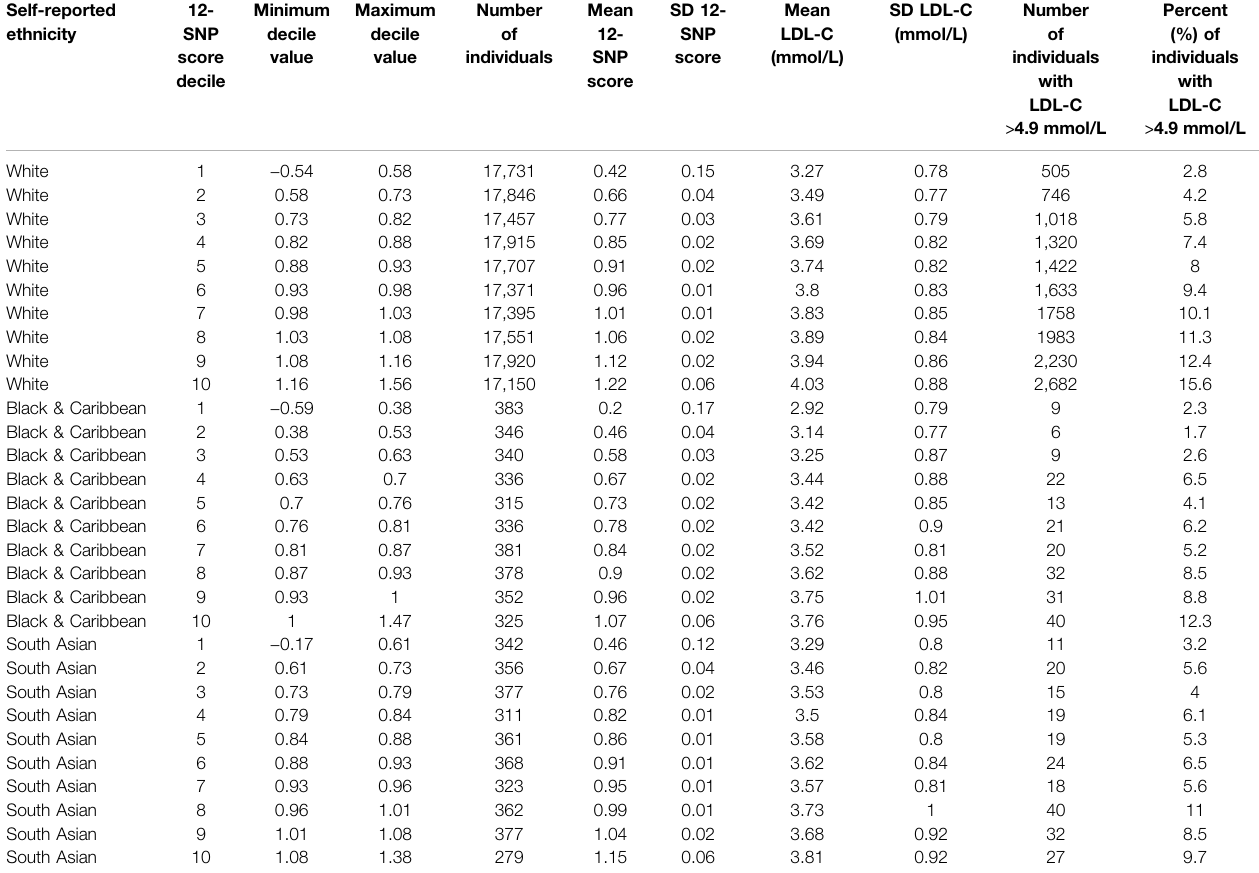
TABLE 2 | Outcome data according toself-reported ethnicity-speci fi c 12-SNP score deciles. The results presented here are using the test data. The training data was used to obtain the 12-SNP score decile cut-off values for each ethnic group studied. LDL-C, low-density lipoprotein cholesterol; SD, standard deviation; SNP, single nucleotide